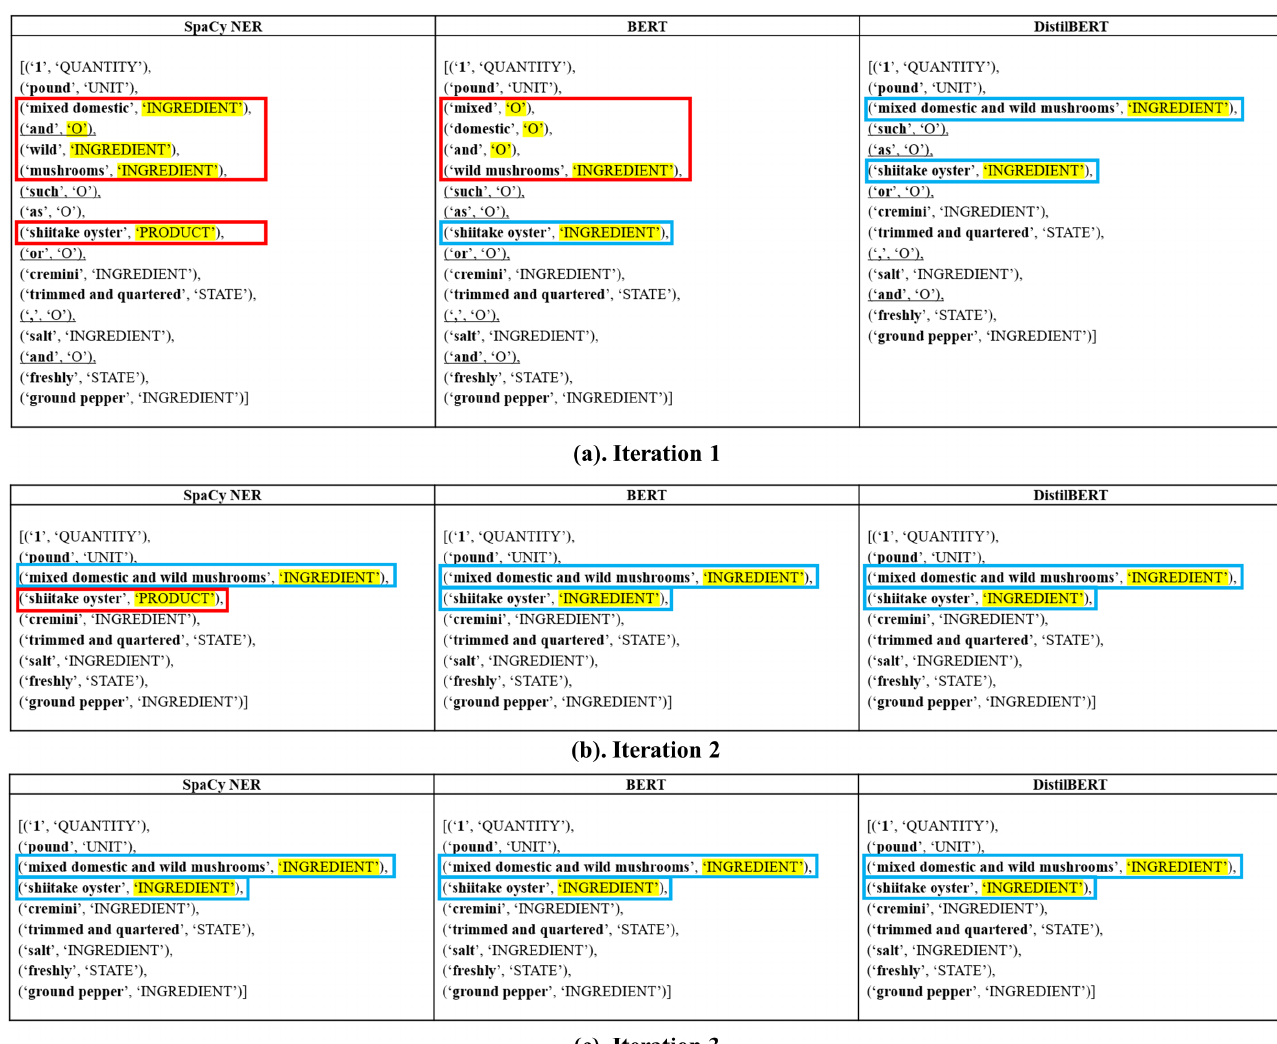
Figure 8. An NER sample generated in scheme 3. Blue and red squares indicate correct and incorrect labeling,